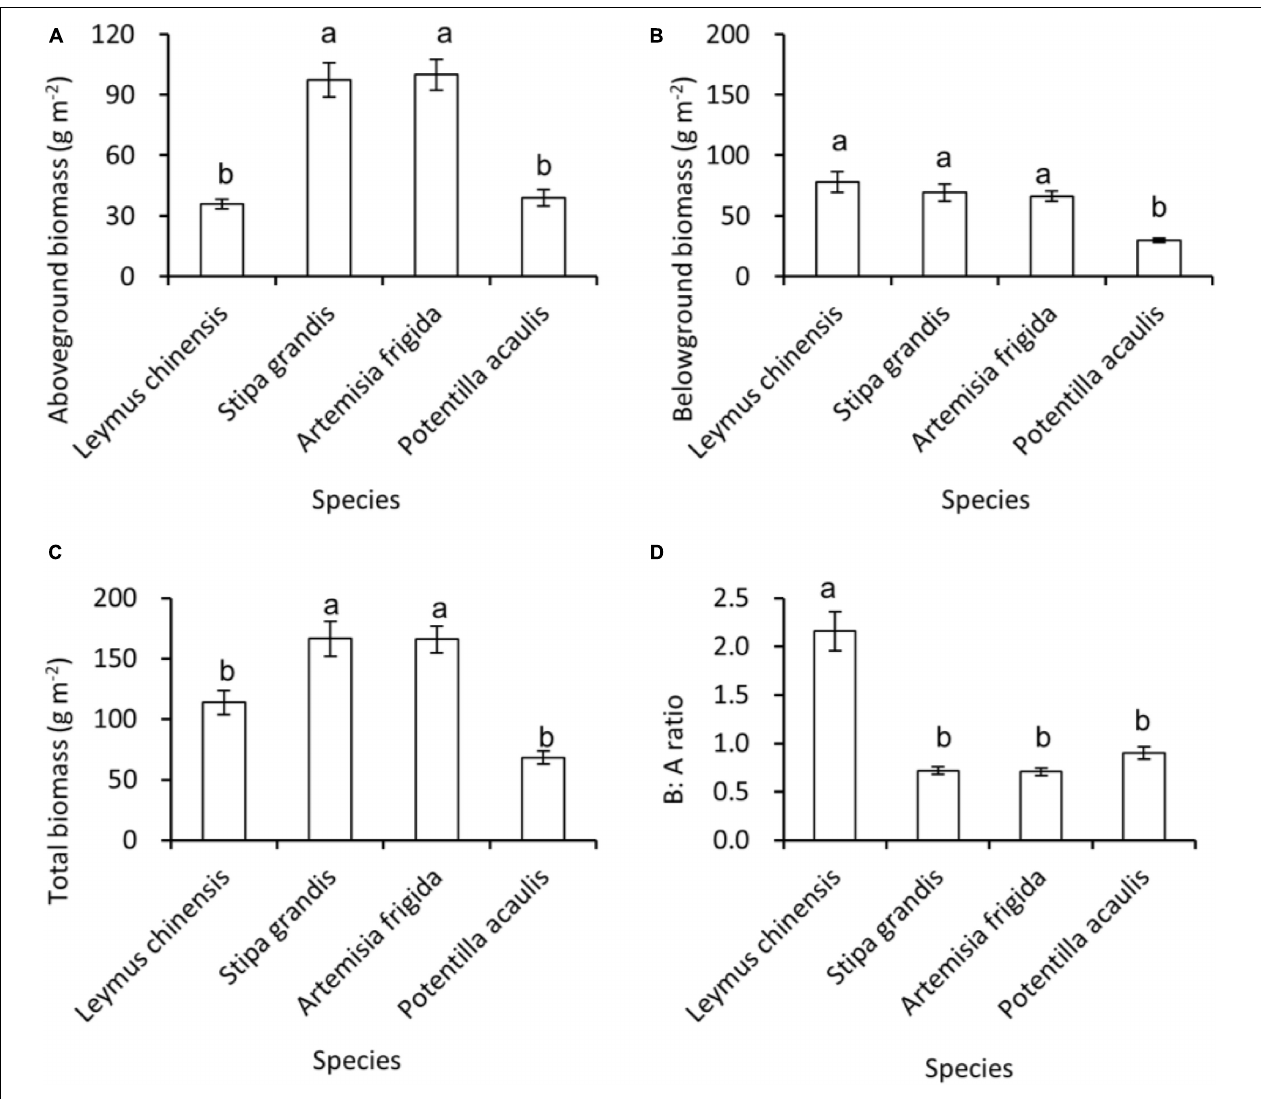
FIGURE 1 | At the pot scale, mean ± SE of (A) aboveground biomass, (B) belowground biomass, (C) total biomass, and (D) B:A ratio (i.e., ratio of belowground biomass and aboveground biomass), across the precipitation gradient, per species, i.e., Leymus chinensis , Stipa grandis , Artemisia frigida , and Potentilla acaulis . Significant ( P < 0.05) differences between species have different letters ( post hoc analyses with Bonferroni corrections).